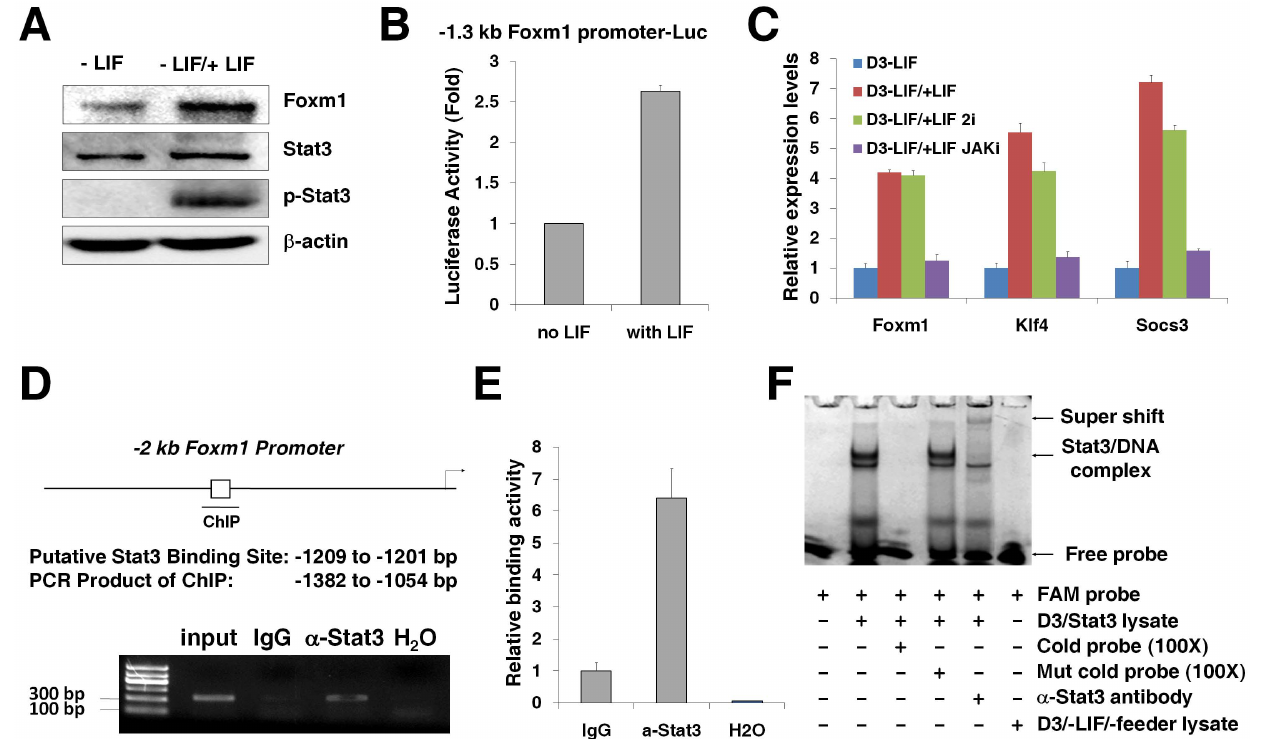
Figure 2. Stat3 regulates the transcription of Foxm1. (A) Response to the activation of LIF signaling. D3 ES cells were cultured in the presence of feeders without LIF for two days and then LIF was added back for another two days. Western blot analyses were performed with antibodies specific for Foxm1, Stat3, phosphorylated Stat3 (p-Stat3), and b -actin. (B) The response of Foxm1 promoter activity to LIF signaling. D3 ES cells were cultured in LIF-free and feeder-free conditions and transfected with a luciferase reporter plasmid containing 2 1.3 kb Foxm1 promoter and the pRL-CMV plasmid (loading control). LIF (1000 U/ml) was added 1 day later and luciferase activities were measured at 24 h after addition of LIF. (C) Sensitivity of LIF-mediated upregulation of Foxm1 to pathway-specific inhibitors. D3 ES cells were cultured without LIF for 4 days and then LIF was added for 6 h. The mix of two inhibitors (2i) of Mek (PD0325901 1 m M) and GSK3 b (CHIR99021 3 m M), or JAK inhibitor I (10 m M) was added 1 hour before the addition of LIF. The mRNA levels of Foxm1, Klf4 and Socs3 were estimated by qPCR. (D–E) Stat3 bound to endogenous Foxm1 promoter. The position of a putative Stat3 binding site (TTCCNGGAA) in 2 2 kb mouse Foxm1 promoter was predicted by gene sequence analysis and the product of ChIP assays was also predicted. The chromatin of D3 ES cells was cross-linked, sonicated, and then immunoprecipitated (IP) with either Stat3 antibody or IgG (control) and the amount of promoter DNA associated with the IP chromatin was estimated by PCR/agarose gel electrophoresis (D) or qPCR (E) with the primers specific to Foxm1 promoter region. The predicted size of the PCR product was 328 bp. (F) Stat3 bound to the Stat3 binding sequence in Foxm1 promoter. Protein lysates were prepared from Stat3-overexpressing D3 ES cells and used for EMSA with a FAM-labeled DNA probe synthesized from the mouse Foxm1 promoter sequence position 2 1218 bp to 2 1192 bp. An unlabeled probe (100 6 ), an unlabeled